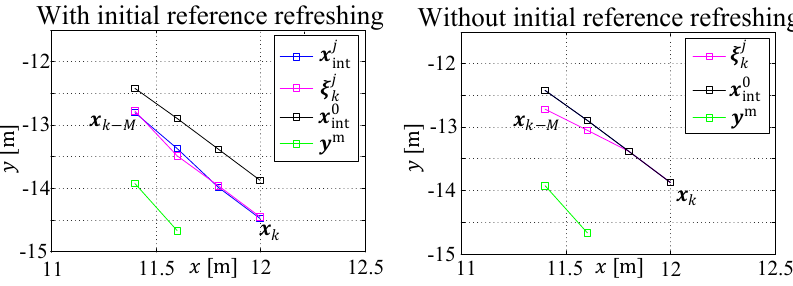
Figure 20. Effectiveness of the anti-freezing heuristic within the optimization window.